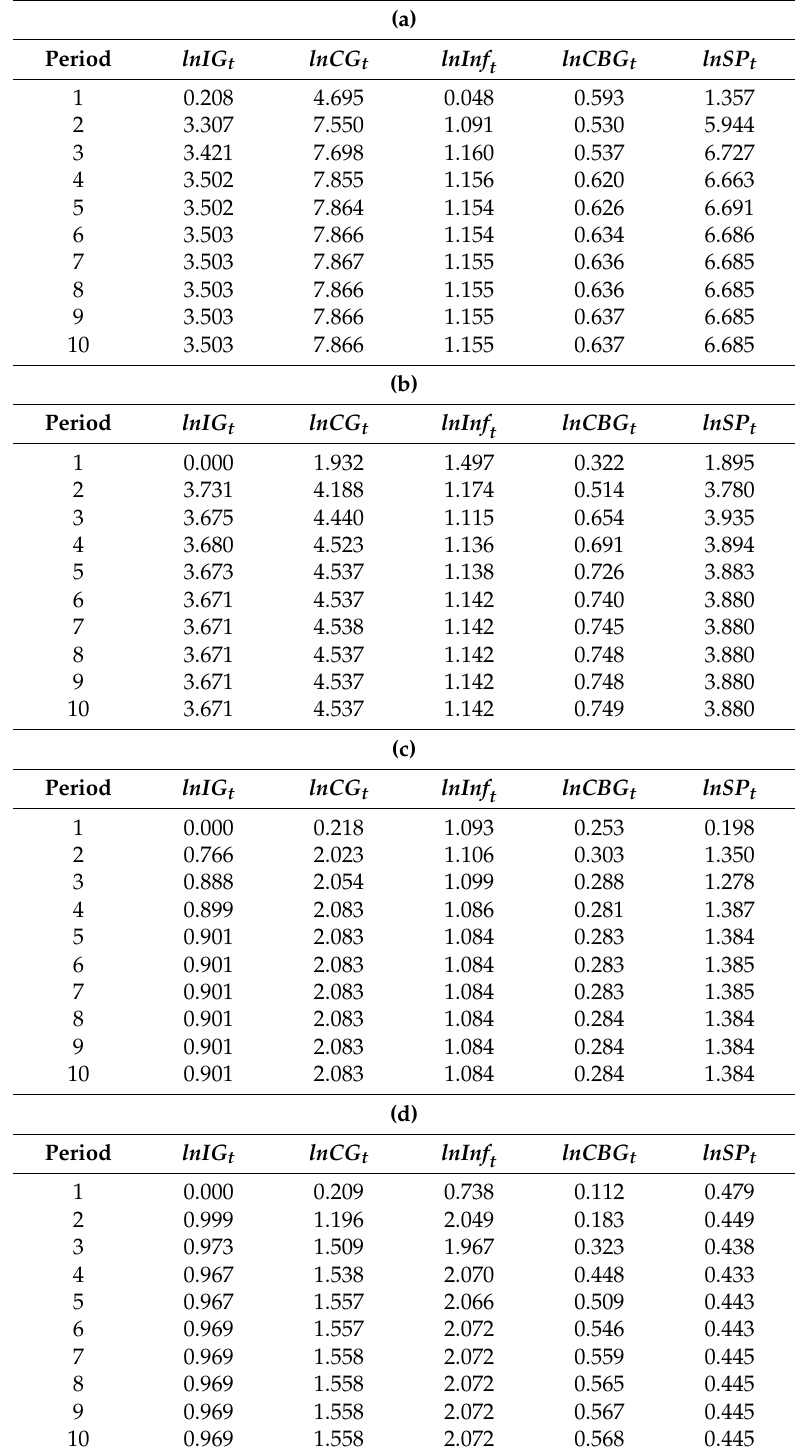
Table 1. Brazil. ( a ) Variance Decomposition of Domestic EPU. ( b ) Variance Decomposition of USA EPU. ( c ) Variance Decomposition of UK EPU. ( d ) Variance Decomposition of Europe